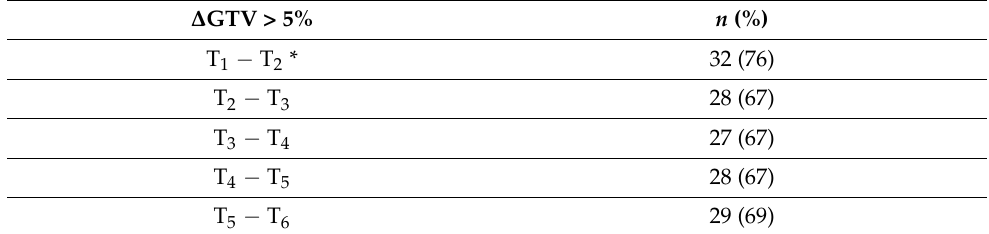
Table 2. The number of patients with a reduction of gross tumor volume by at least 5% ( ∆ GTV > 5%) between each week of chemoradiation ( N = 42).